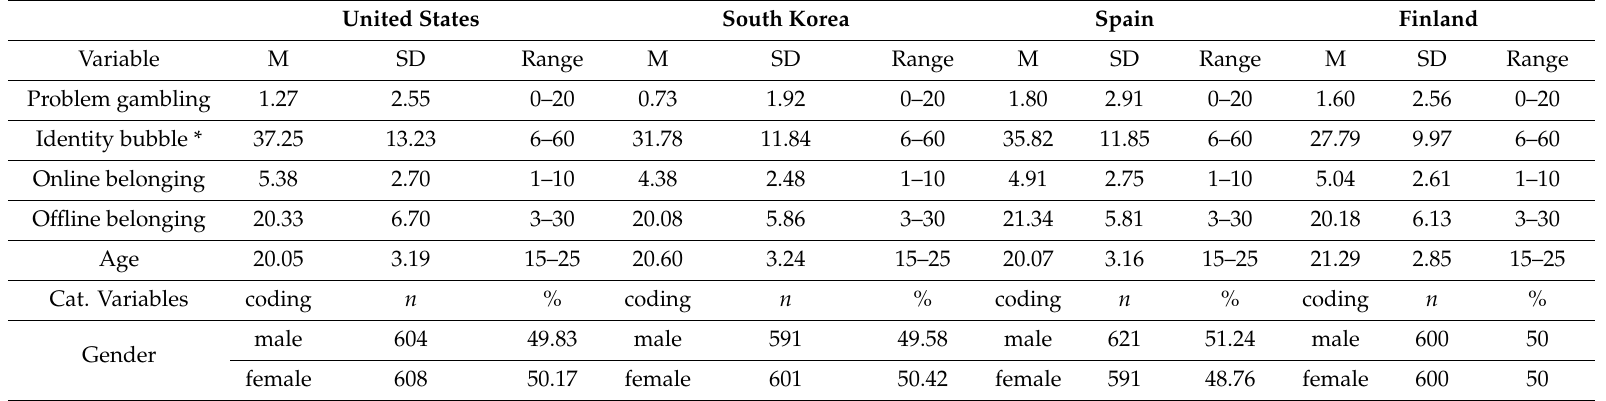
Table 1. Descriptive Statistics.